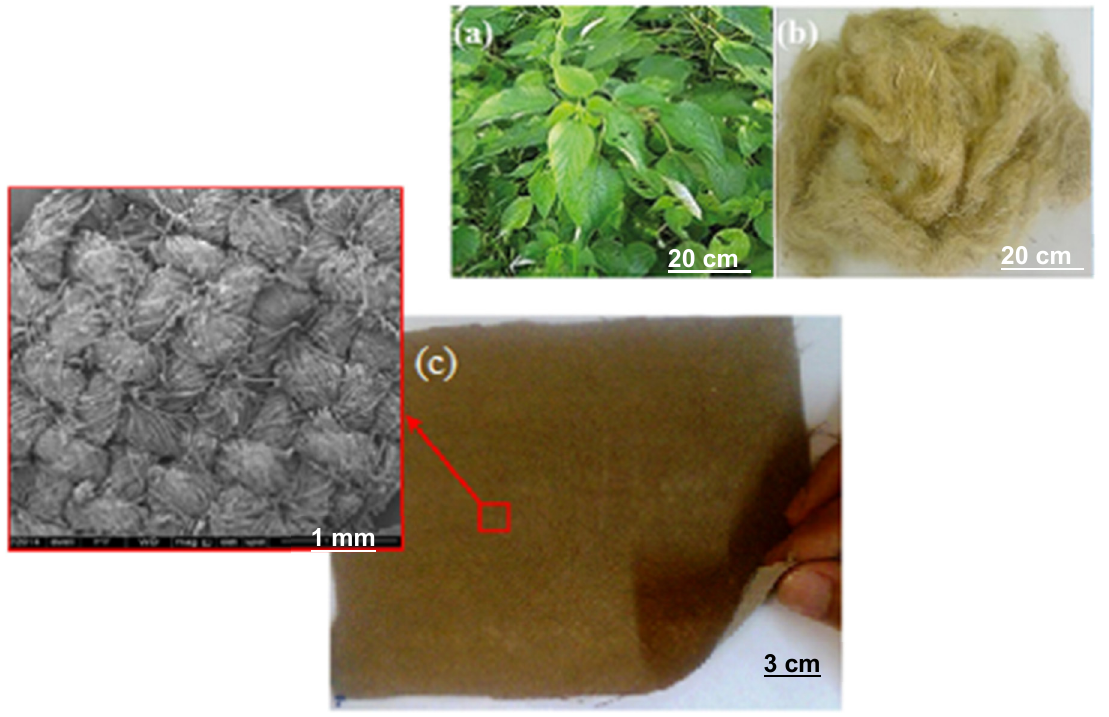
Figure 1. The Boehmeria nivea plant ( a ), a bunch of nonwoven ramie fibers ( b ) and the ramie fabric ( c ). Reproduced with permission from [38,51].